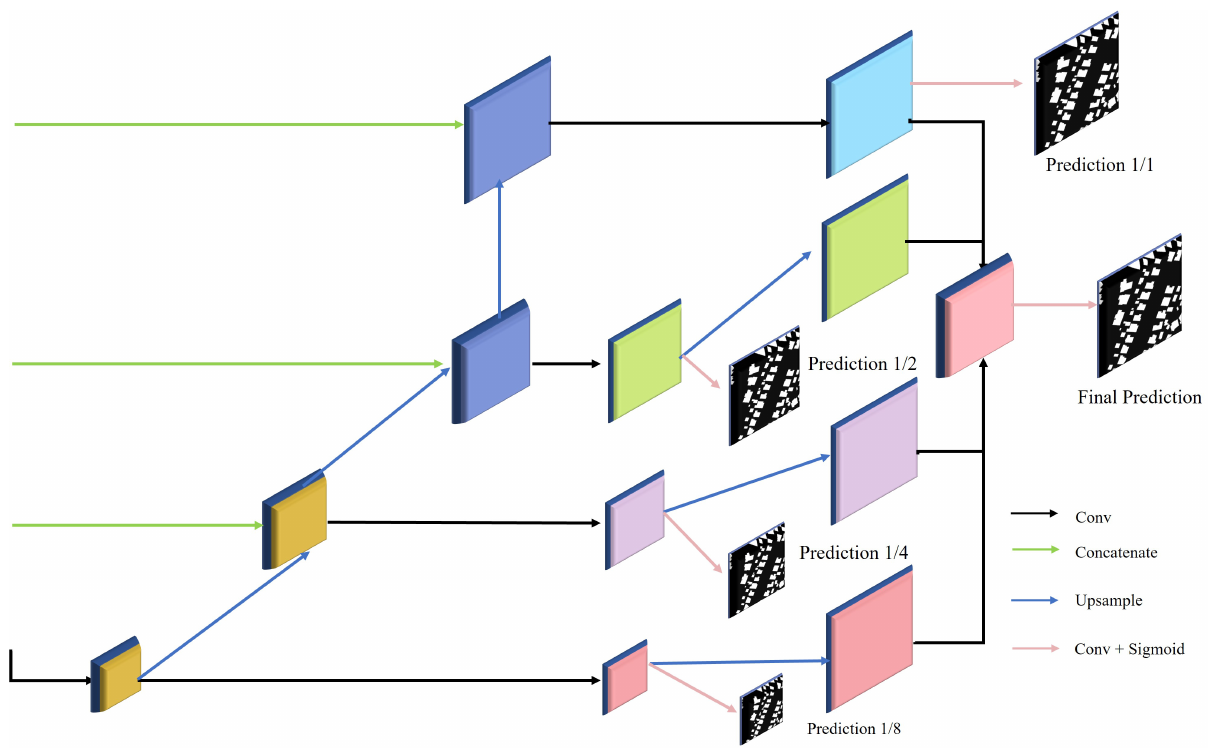
Figure 12. Multi-scale